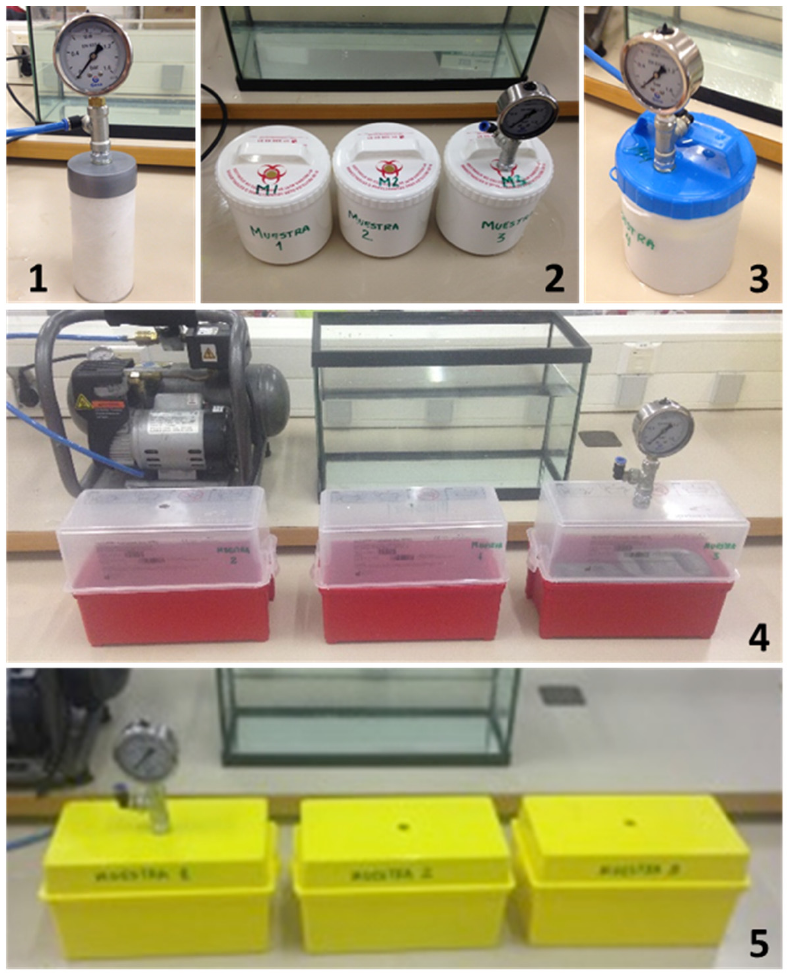
Figure 3. Packaging system with air pressure connector and pressure gauge before the pressure leakproof tests.